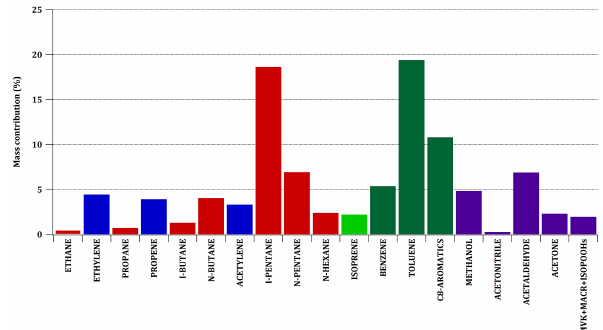
Figure 2. Average highway tunnel profile (in mass contribution, %) assessed from traffic peaks concentrations and subtracted from nighttime values. Red, blue, light/dark green and purple bars cor- respond to alkanes, alkenes-alkynes, isoprene/aromatics and oxy- genated species,